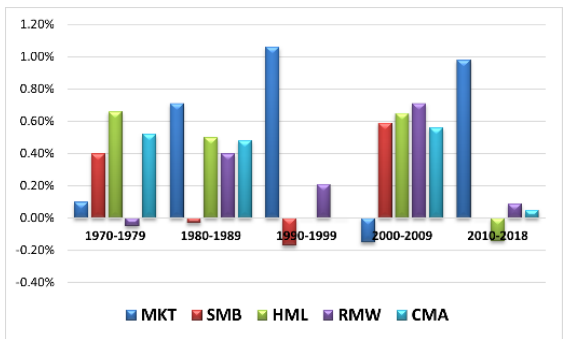
Figure 2. Five-factor premiums by decade (1970–2018).